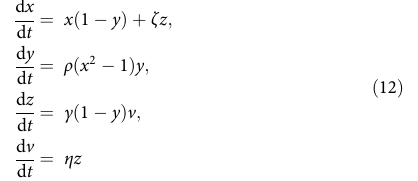
Table 1. The time series evolution of the neuron state x ð t Þ ¼ V ð t Þ ; m ð t Þ ; h ð t Þ ; n ð t Þf g was computed by integrating current protocols with Eq. (11). The membrane voltage time series was assimilated with the SSN model (Eq. (10)). This approach allowed the dynamics of HH gate variables — which cannot be observed in real neurons — to be compared with the dynamics of gate variables in the SSN model. The membrane voltage observed in biological neurons was re-scaled from [ − 100, + 45 mV] to [0, 1.8 V] to fi t the voltage range of the VLSI chip hosting the SSN microcircuits (Supplementary Fig. 12). The conversion formula from the observed membrane voltage ( V mem ) to the SSN membrane voltage V was V ð mV Þ ¼ 12 : 414 ´ V mem ð mV Þ þ 1241 : 4.